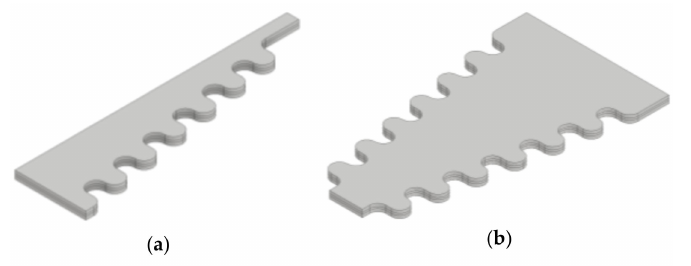
Figure 8. Trapezoidal ( a ) and inverted trapezoidal ( b ) PEH segments with wavy edges (added stress concentrators).